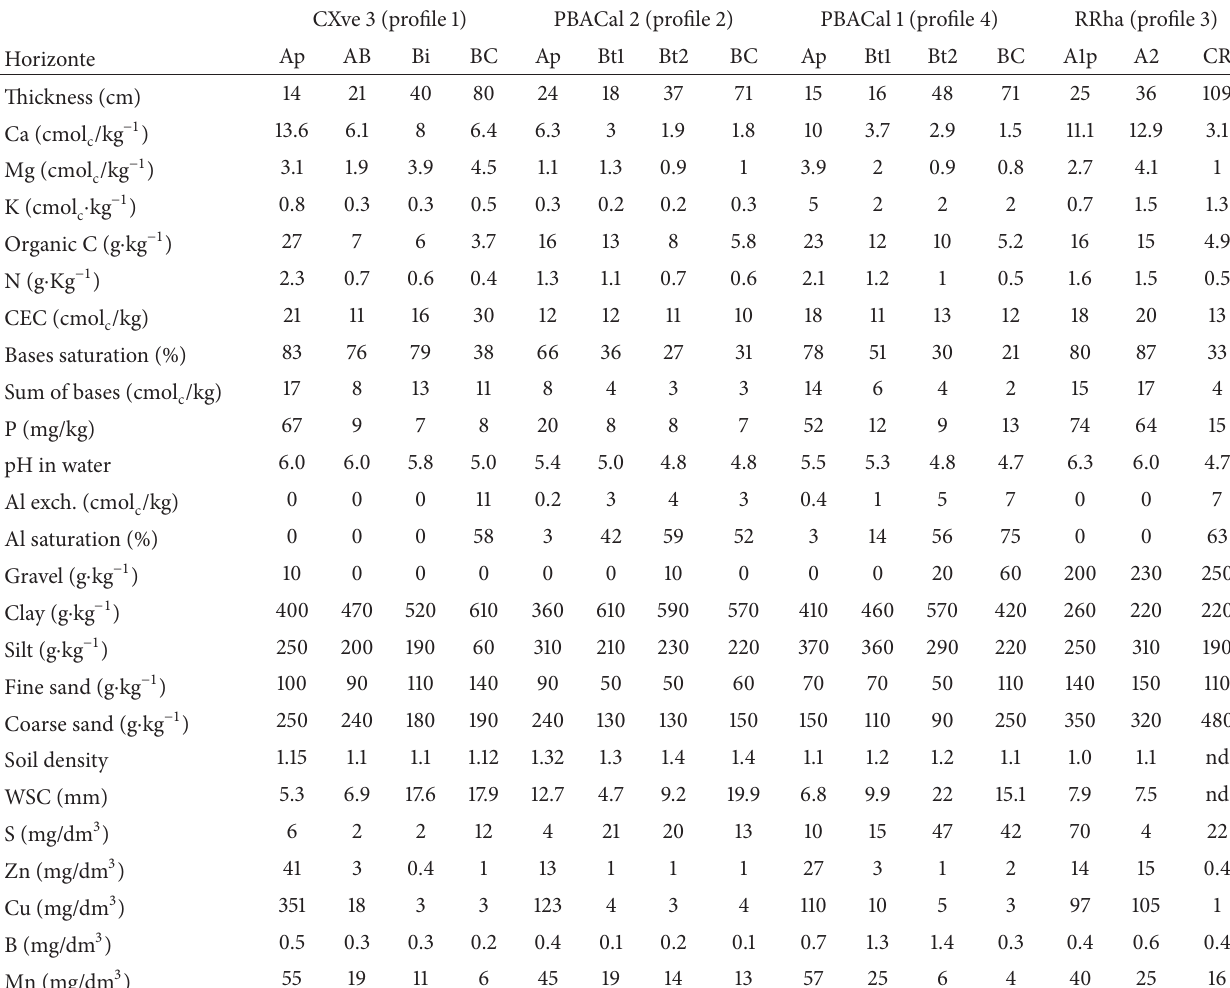
Table 2: Physical and chemical parameters of the soil profiles for each horizon.